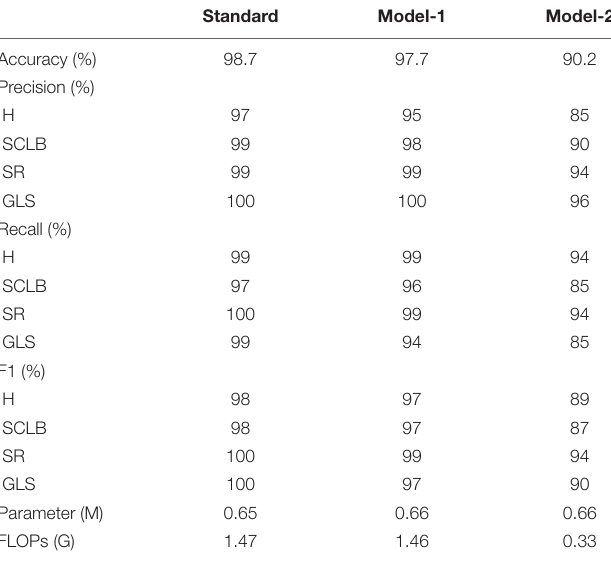
TABLE 3 | Research of importance of the self-attention.